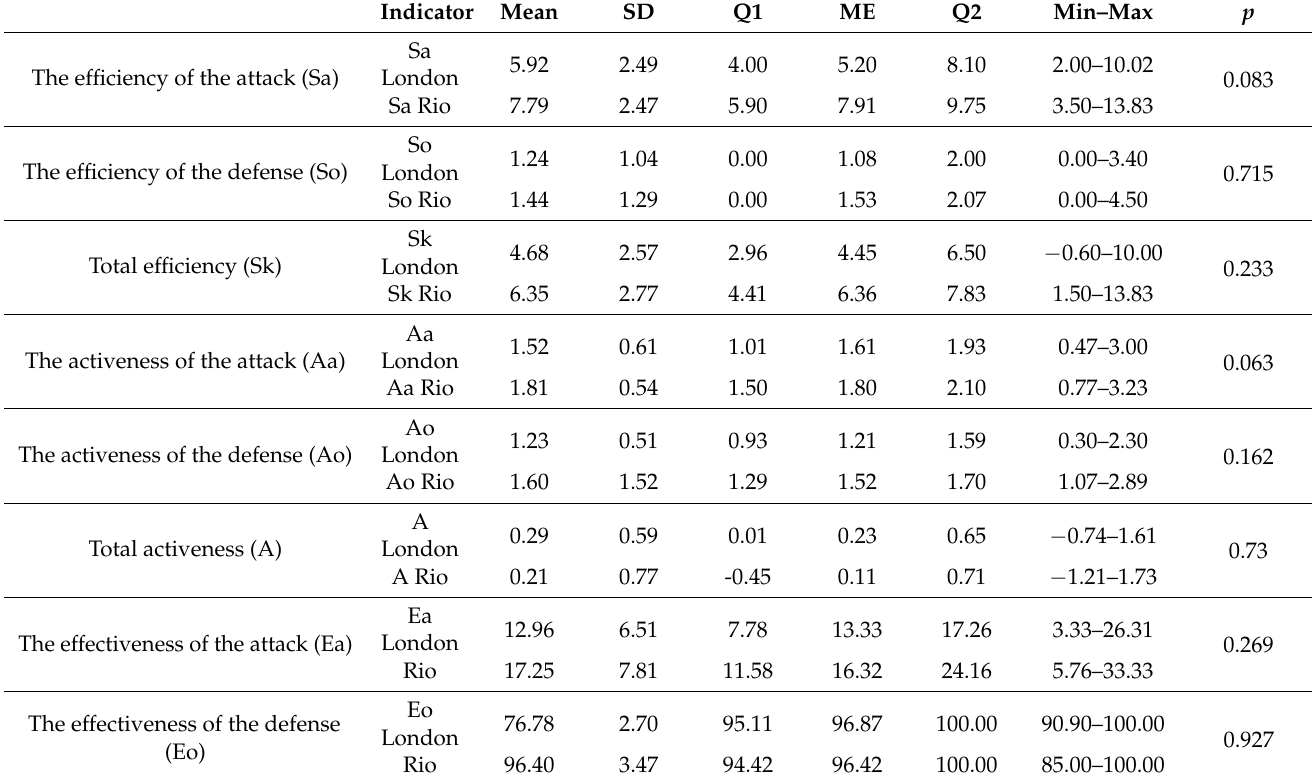
Table 3. The efficiency, activeness, and effectiveness of the attack and defense in London and Rio. Indicator